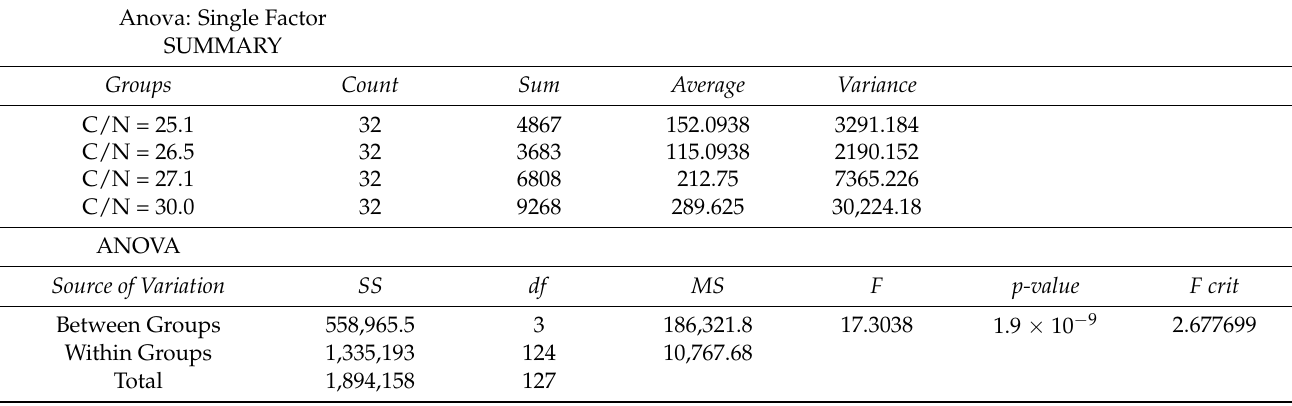
Table A3. One-way (ANOVA) test for daily biogas yield from the last four reactors.